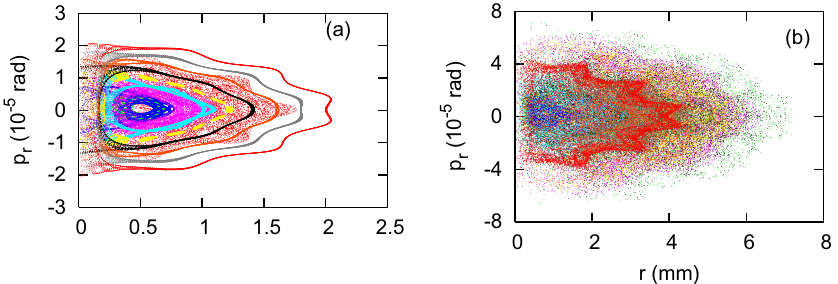
(cid:5) 0 : 285 and (cid:8) (cid:5) 0 : 295 . Tune shifts are (a) (cid:12) (cid:5) 0 : 06 x y